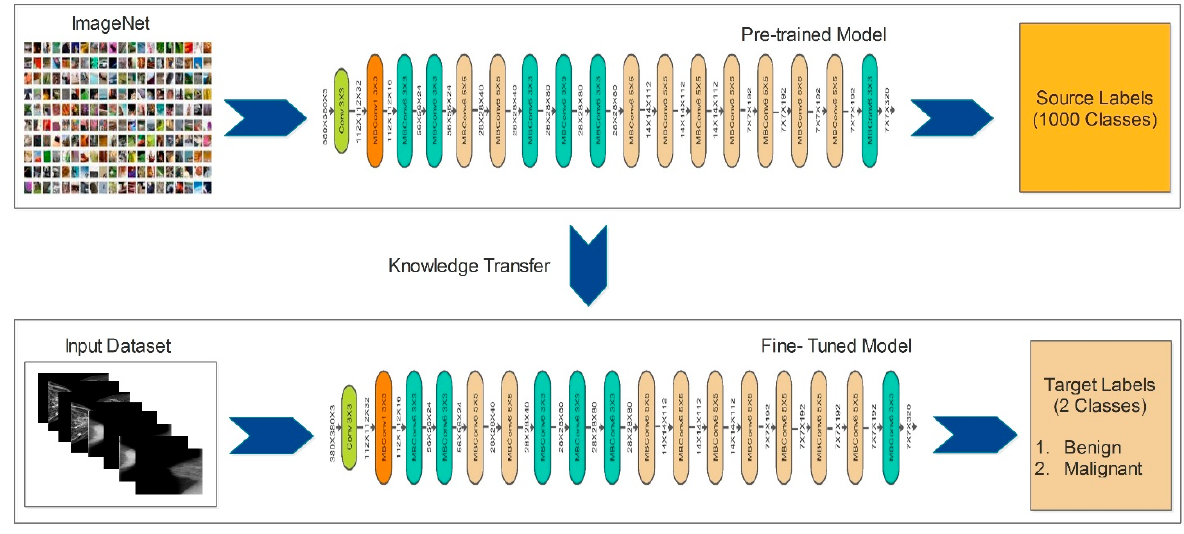
Figure 7. Visual process of deep transfer learning for breast cancer classi fi cation .